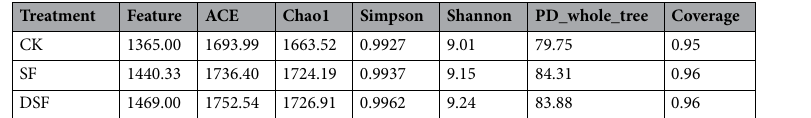
Table 3. Alpha diversity analysis of rice rhizosphere microorganisms under different fertilization modes of slow-release fertilizer. Feature: the number of OTUs; ACE, Chao1, Simpson, Shannon, PD_whole_tree represent each index respectively; Coverage is the coverage rate of the sample library. Values are the mean of three replicates.